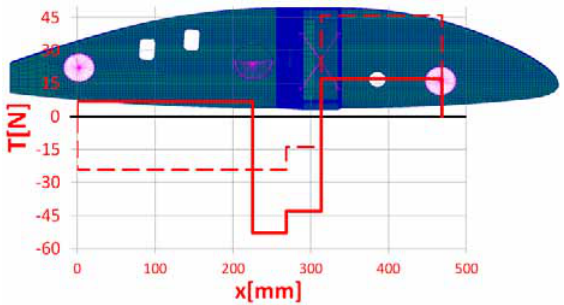
Fig. 4. Shear force distribution in the root rib: Loading A and Loading B